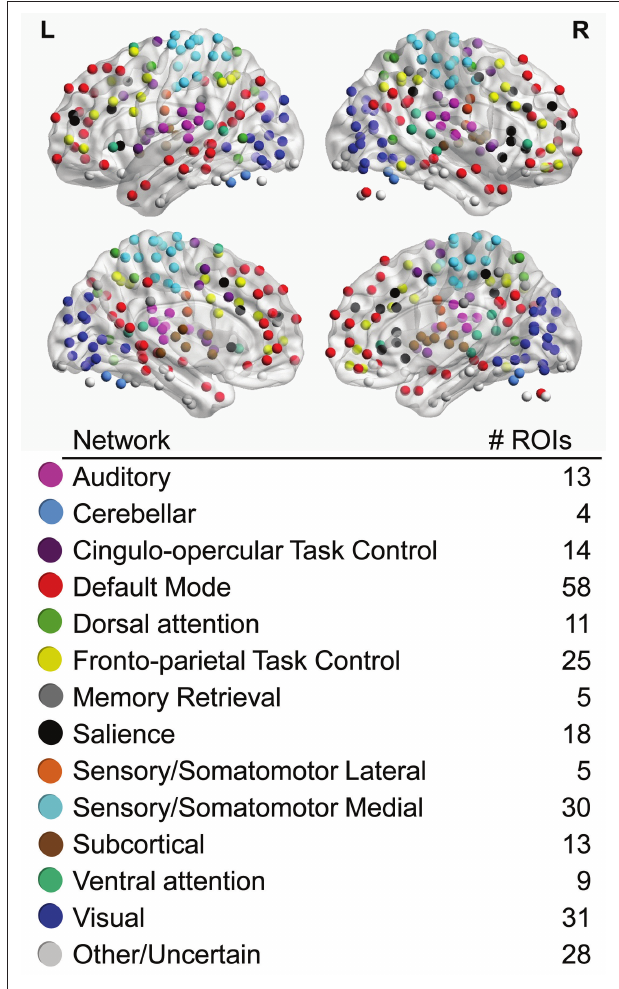
FIGURE 1 | Regions-of-interest (ROIs), color-coded by association with large-scale networks, are visualized on left (L) and right (R) lateral (upper) and medial (lower) cerebral hemispheres. The total number of ROIs associated with each large-scale network is